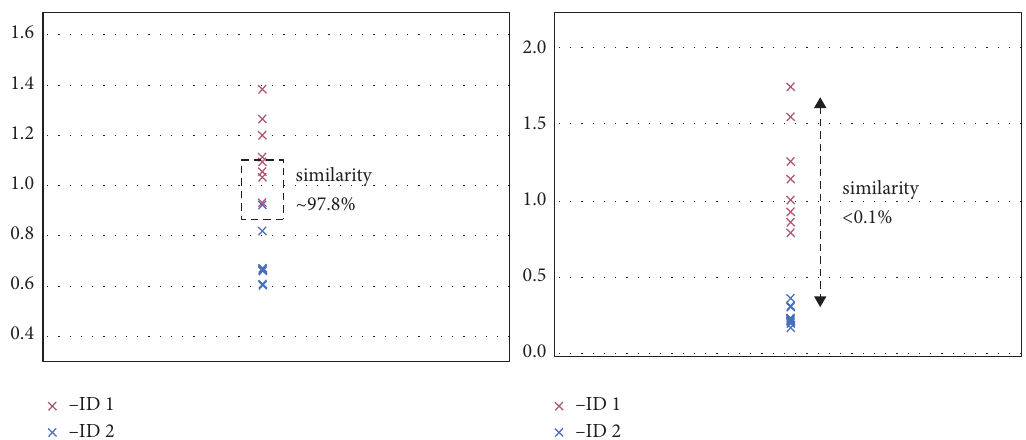
Figure 10: Red X represents trained subject; blue X represents test subject. (a) Image represents two similar subjects and (b) two different subjects. Gait parameter here was footstep speed.